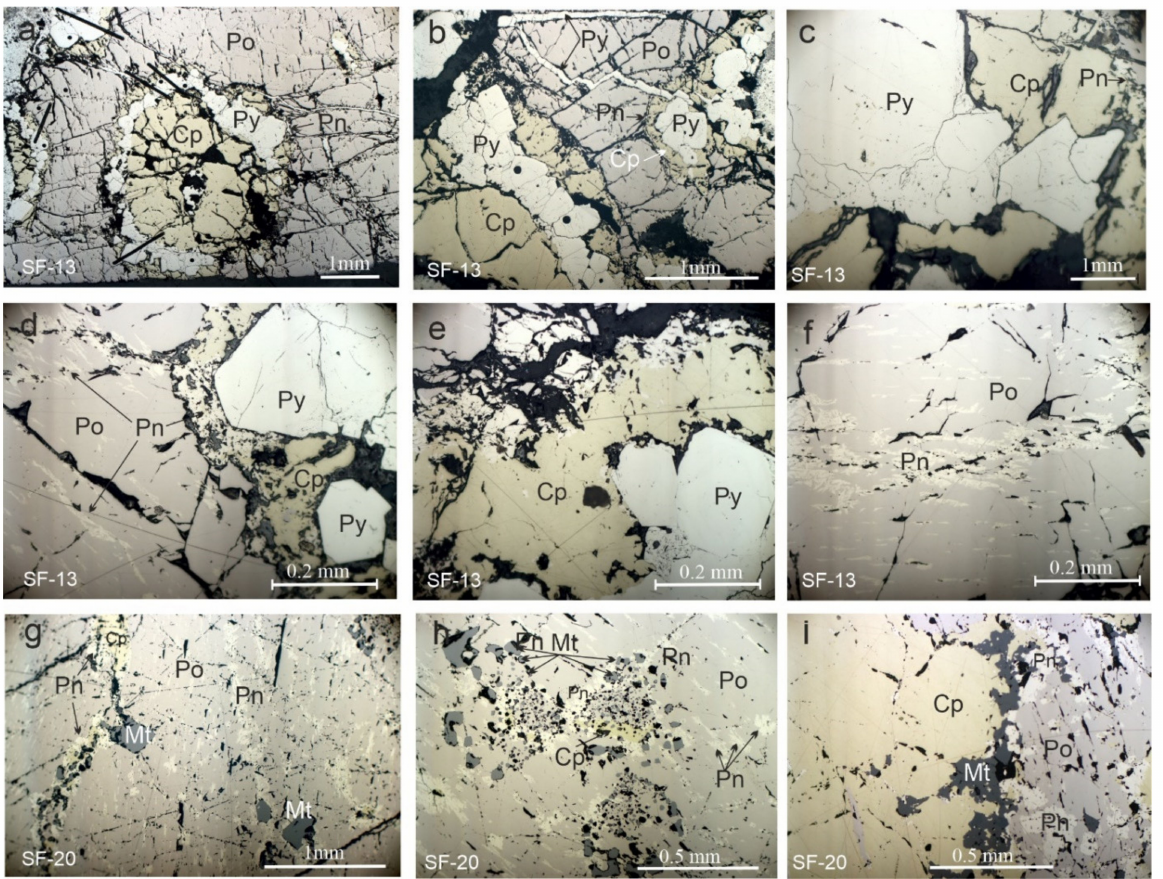
Figure 3. Textures and parageneses of sulfides in massive ores from boreholes SF-20 ( a – c ), and SF-13 ( d – i ), reflected light. ( a – c ) Zoned sulfide segregations ( a ), in pyrrhotite (Po): a core composed of chalcopyrite (Cp) along the margin of which occur granular pyrite (Py), and a thin pentlandite (Pn) rim along the chalcopyrite ( b , c ) within a pyrrhotite matrix; ( d – f ) sulfide parageneses in which Pn is represented by two generations: lamellae of exsolution in Po ( d , f ) and rims along the border of chalcopyrite segregation ( d , e ); ( g ) lamellae of pentlandite (Pn) and veinlets of magnetite